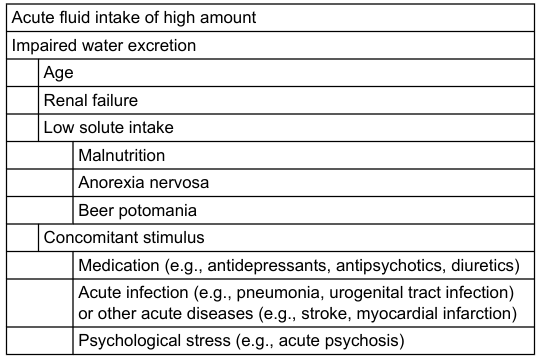
Table 2: Factors predisposing to